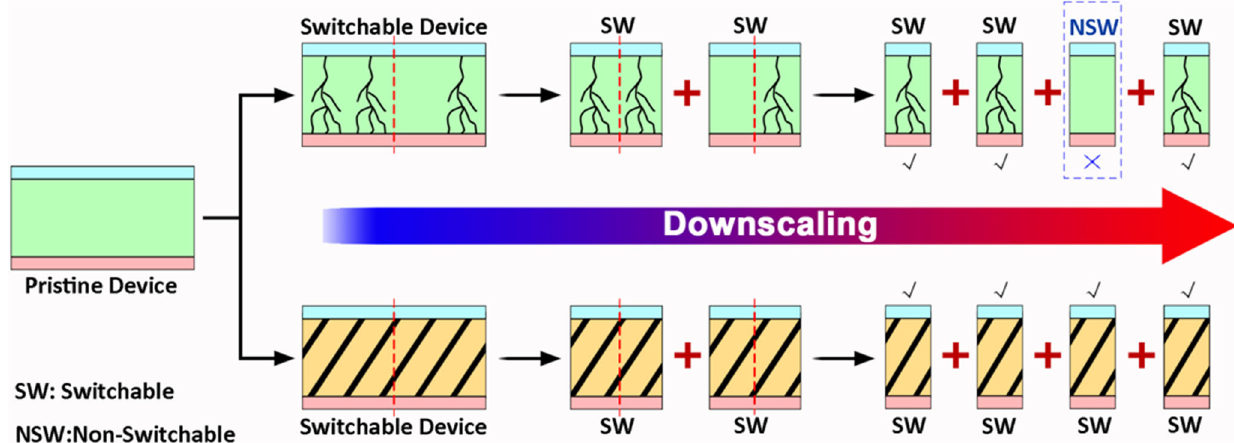
Fig. 1 Localized and bulk switching mechanisms. Schematic illustration of the fi lamentary (upper panel) and bulk phase (lower panel) resistive switching phenomena in polymer memristor devices and their